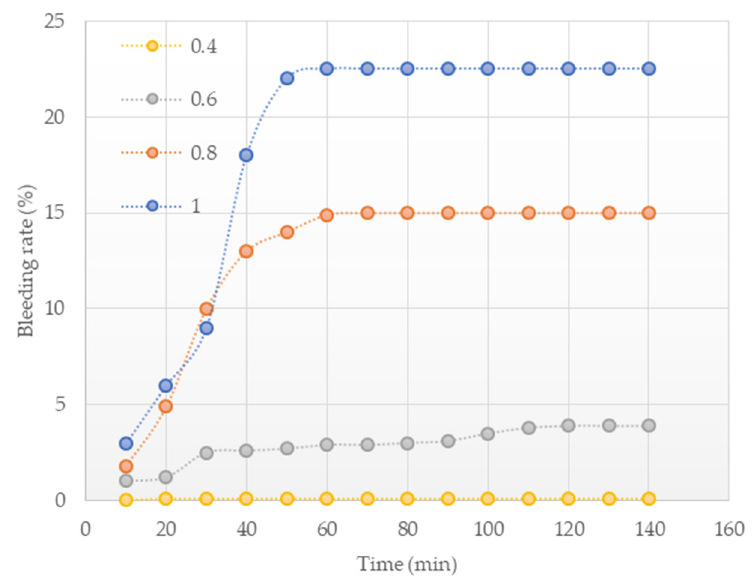
Figure 6. Bleeding rate of cement slurry with different water–cement ratios.